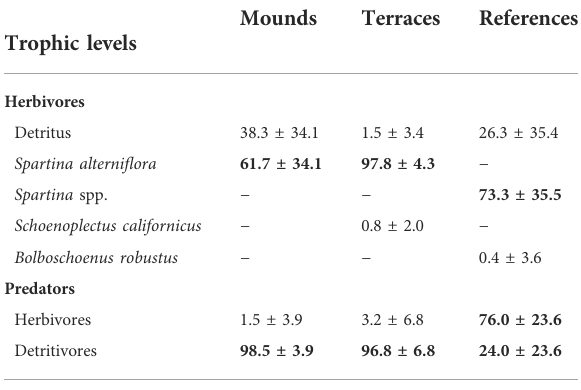
TABLE 2 Mixing model estimates of end member contributions to herbivore and predator diets in reference and restored (mound or terrace) marshes (mean ± SD). Bolded values indicate the primary contributor to the diet, and blank cells indicate that a source did not occur in a given habitat type.